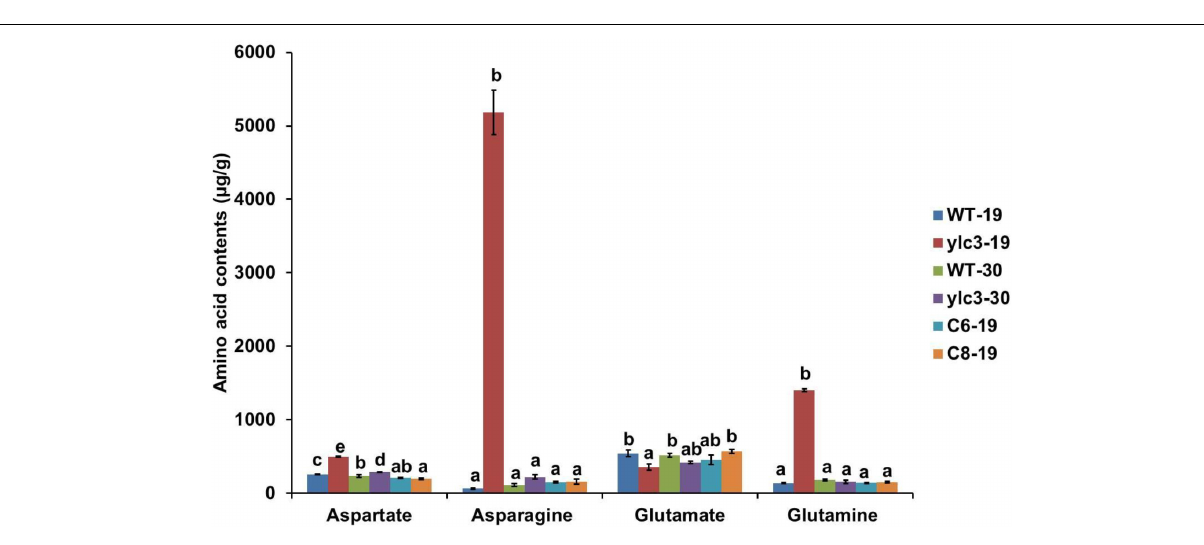
25 chloroplast-encoded proteins in different thylakoid